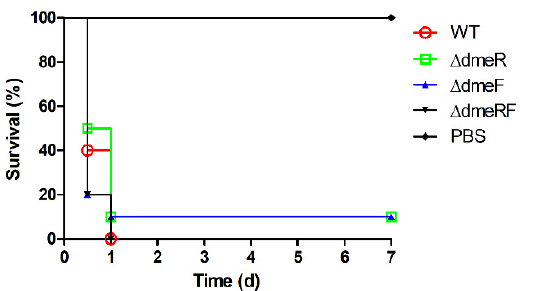
Figure 9. Survival curves of mice infected with one of four V. parahaemolyticus strains or PBS. Ten mice per treatment were intraperitoneally infected with 1 × 10 8 CFU of the WT, ∆ dmeR , ∆ dmeF , or ∆ dmeRF strains, or injected with 100 µ L of PBS as the control. The data were analyzed using the log-rank test.